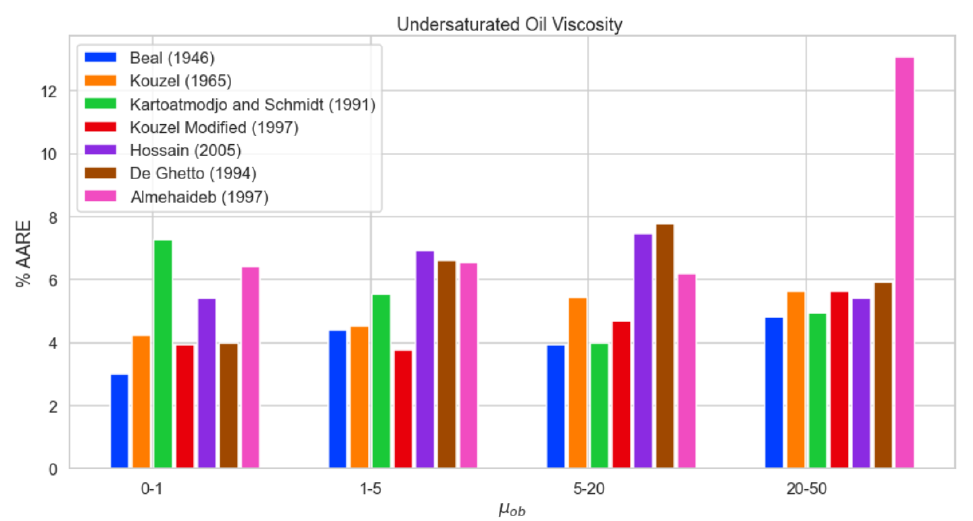
Figure 9. AARE bar plot of the most accurate correlation(s) of each